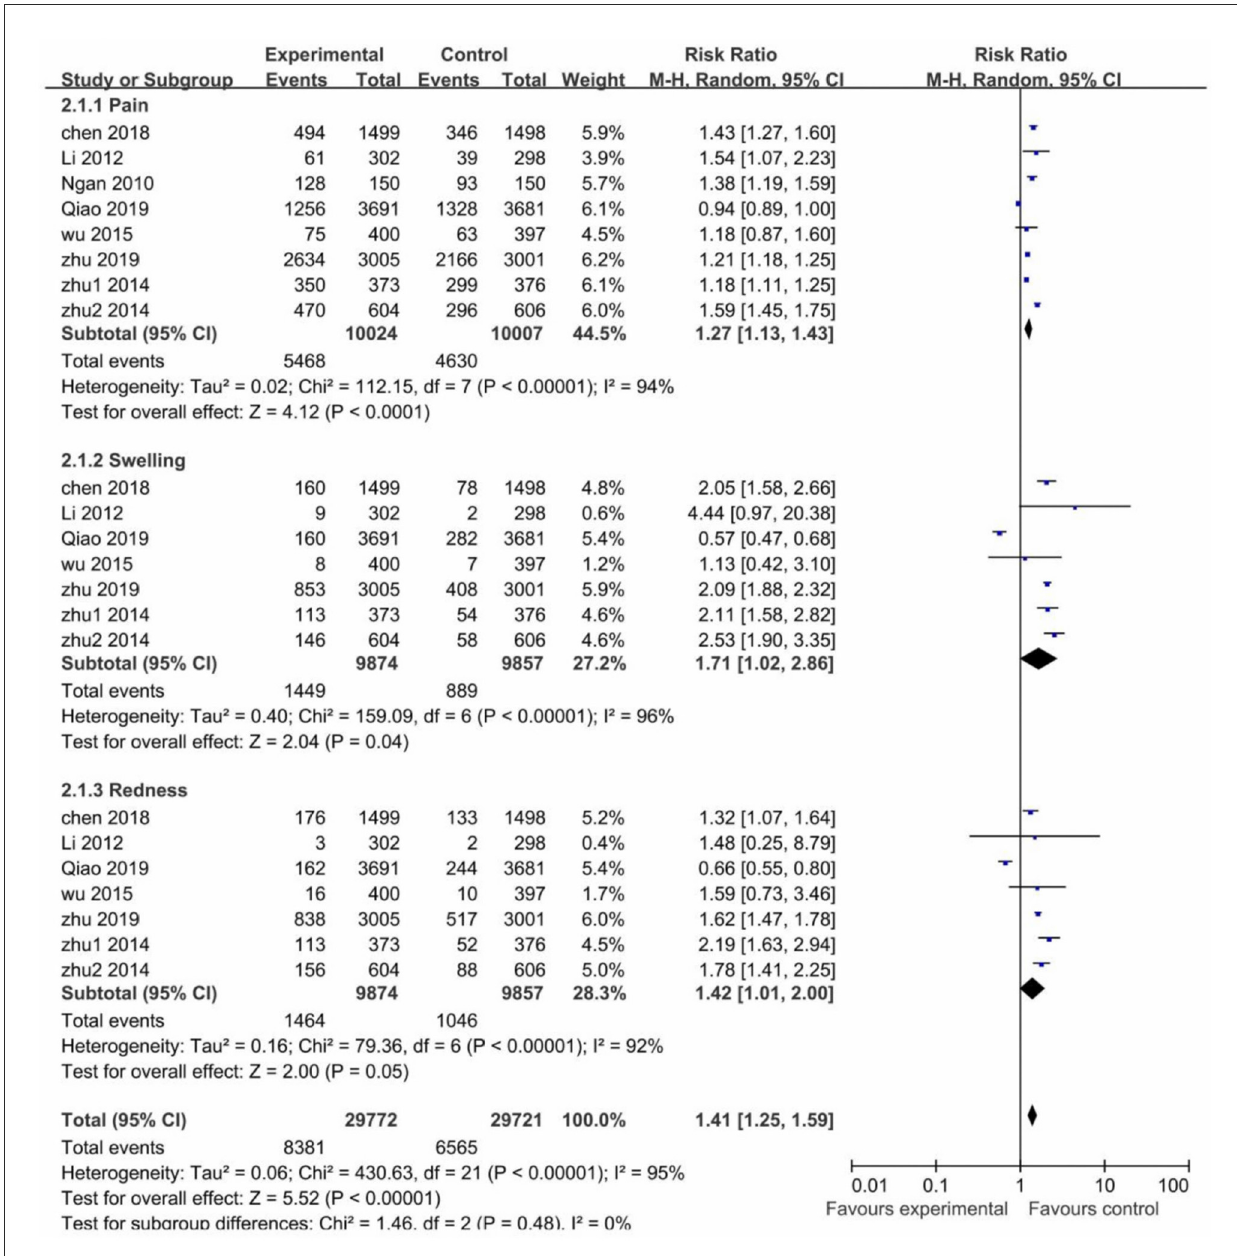
FIGURE5 The risk of local adverse